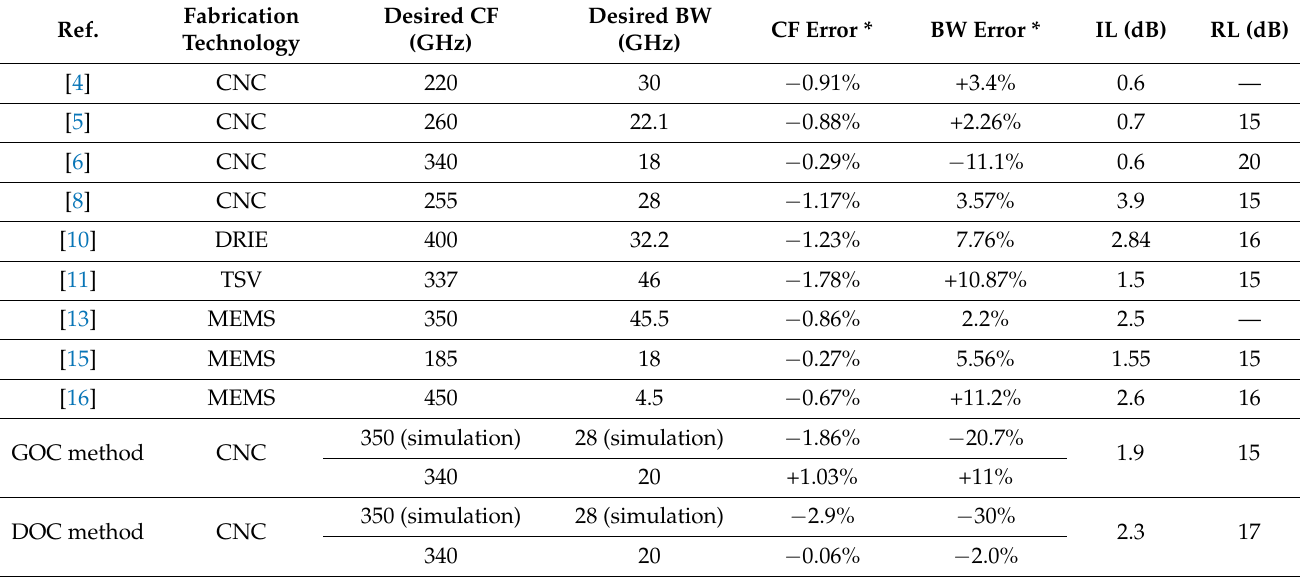
Table 3. Comparisons with Other Previous